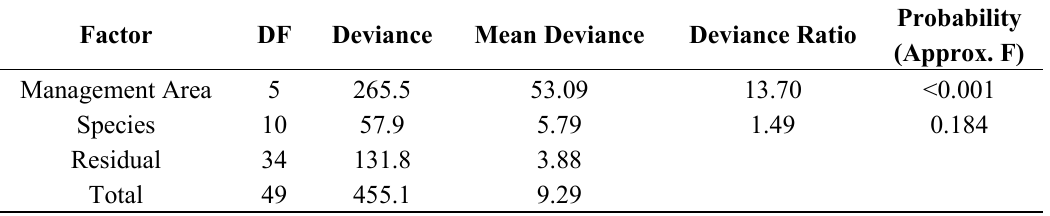
Table 3. Summary of generalized linear model (GLM) analysis for categories